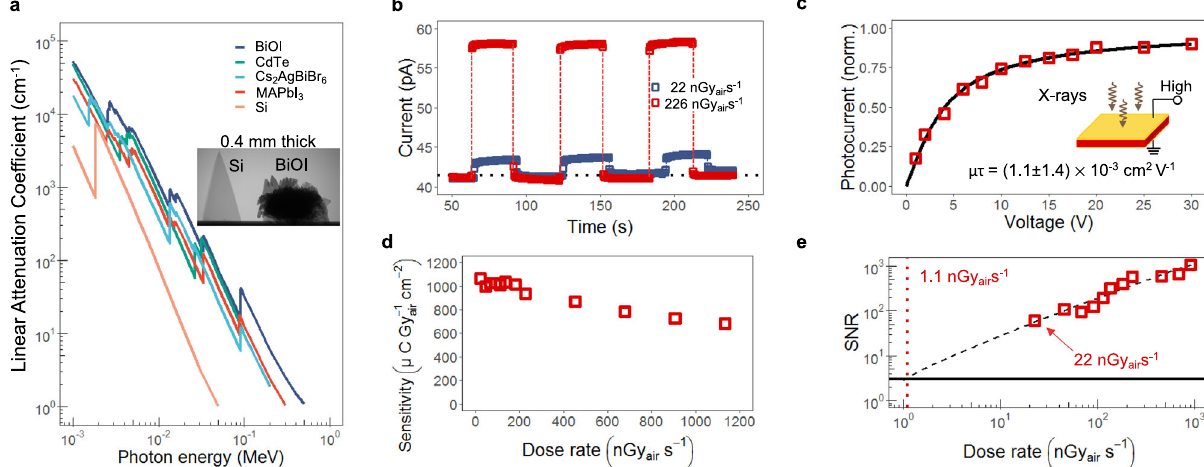
Fig. 4 | X-ray detection properties of BiOI single crystals and performance of devicesintheperpendicularcon fi guration.a Linearattenuationcoef fi cientsasa function of photon energy for BiOI (dark blue), CdTe (green), Cs 2 AgBiBr 6 (light blue),MAPbI 3 (red)andSi(pink).InsetareradiographsofSi(0.4mmthick)andBiOI crystals stacked together to give the same thickness of 0.4mm. The transmittance through Si is 78%, whereas through BiOI, it is 2%, demonstrating the high stopping power of BiOI. b Photocurrent measurement of the perpendicular BiOI devices at X-ray dose rates of 22nGy air s − 1 (dark blue) and 226nGy air s − 1 (red). c Photocurrent ofperpendicularBiOIdevicesilluminatedwithX-rays(squaresymbols)and fi twith